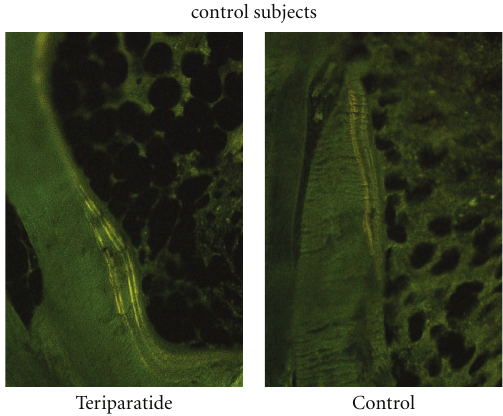
Figure 3: Early e ff ects of teriparatide to increase bone modeling . Subjects were labeled before and 1 month after exposure to teri- paratide. The control subjects did not receive treatment. The two sets of labels in the teriparatide-treated subject clearly demonstrate a marked increase in bone formation after teriparatide exposure. From Lindsay et al. [27].